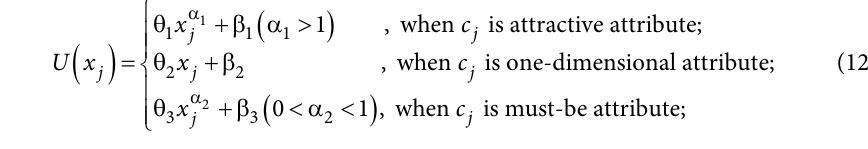
Table 1. Three types of consumer satisfaction functions Utility